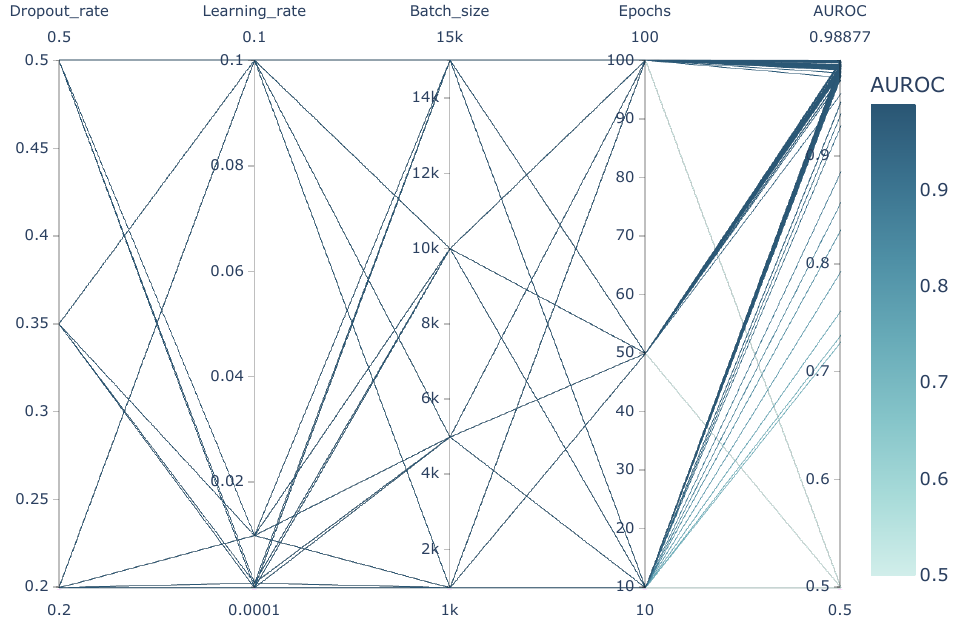
Figure 8. Performance of R-CRISPR with different combinations of